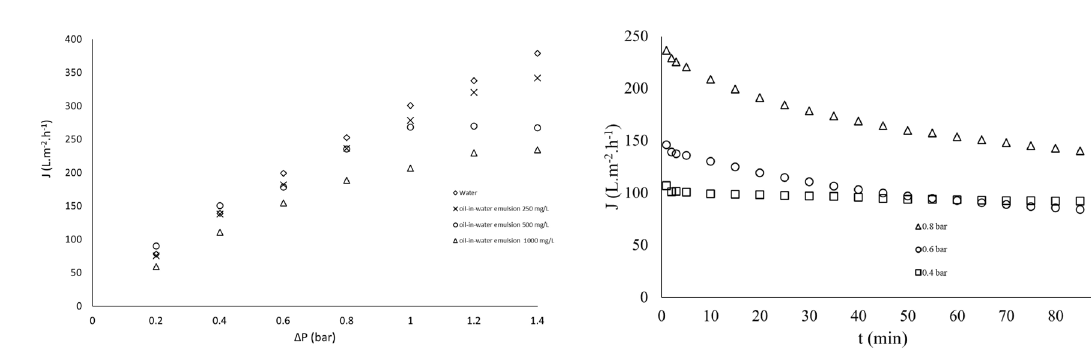
Figure 6. Permeate fluxes in different pressures for M1 membrane under different conditions.